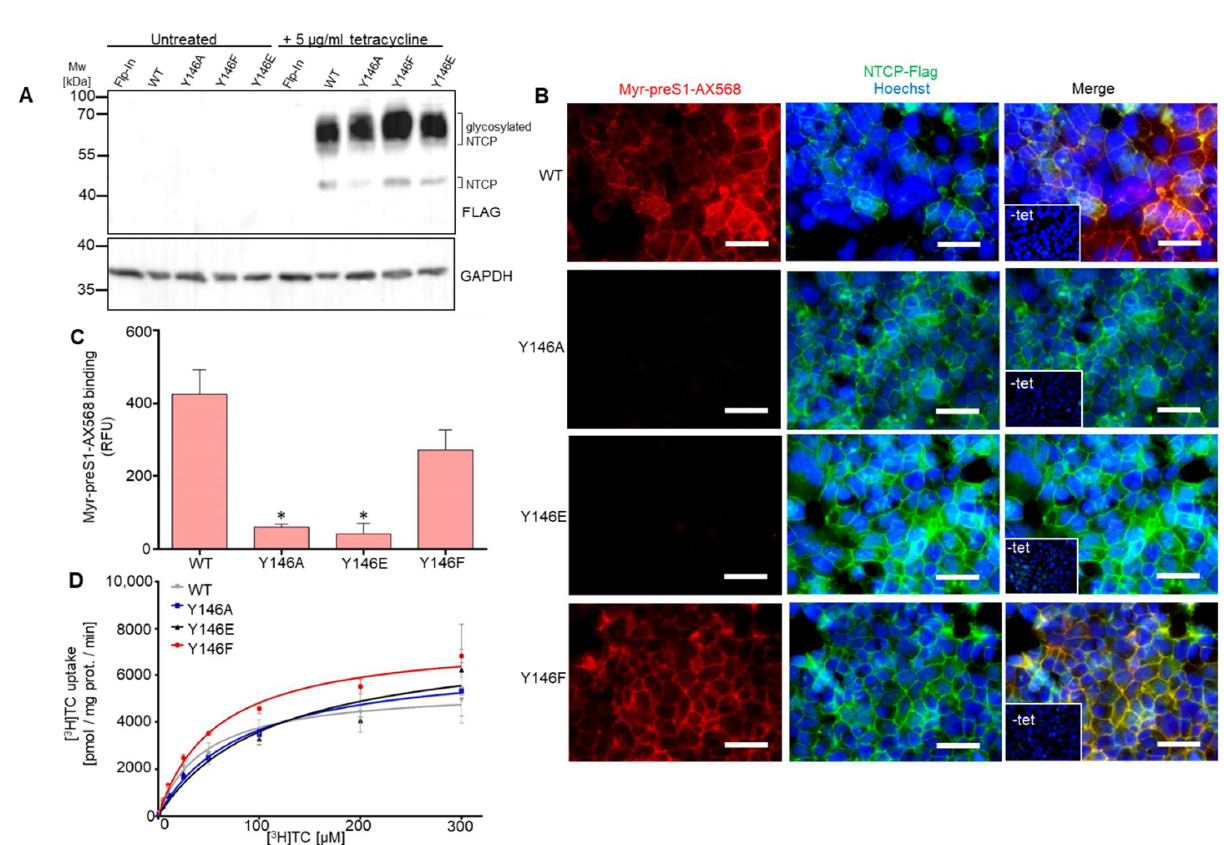
Figure 5. TC transport kinetics in stably NTCP-transfected HEK293 cell lines. In addition to wt NTCP, the cDNA constructs of the Y146A, Y146E, and Y146F mutants were stably transfected into the tetracycline-inducible T-Rex Flp-In HEK293 cells and single cell clones were selected. ( A ) NTCP protein expression in the stably transfected cell lines with or without addition of tetracycline (5 µg/mL) for 48 h. Cell lysates were processed for Western blot analysis using an anti-FLAG antibody. Expression of GAPDH served as loading control. MW, molecular weight marker. ( B ) Binding of the myr-preS1-AX568 peptide (red) to HEK293 cells stably expressing the wt NTCP, as well as the NTCP Y146A, Y146E, and Y146F mutants. The NTCP protein was counterstained with the rabbit anti-FLAG primary and the Alexa Fluor 488-labelled goat anti-rabbit secondary antibodies (green). Nuclei were visualized with Hoechst dye (blue). Scale bars: 40 µm. ( C ) For quantification of myr-preS1-AX568 peptide binding to NTCP, fluorescence images were captured on Leica DMI6000 B fluorescent microscope and fluorescence signals were quantified with the LAS-X imaging software (Leica) by determining cell-based fluorescence in defined regions of interest (ROI). Data are presented as mean background-subtracted relative fluorescence units ± SD of three independent experiments. EV, empty vector. * Significantly lower compared to wt NTCP with p < 0.001 according to one-way ANOVA with Dunnett’s multiple comparison post-hoc test. ( D ) Concentration-dependent uptake of [ 3 H]TC was analyzed in HEK293 cells stably expressing the wt NTCP, as well as the NTCP Y146A, Y146E, and Y146F mutants. Cells were treated with 5 µg/mL tetracycline for 48 h to induce carrier expression. Non-transfected T-Rex Flp-In HEK293 cells served as control. Specific uptake of [ 3 H]TC was calculated by subtracting non-specific uptake of the T-Rex Flp-In control cells from uptake into carrier-overexpressing HEK293 cells. The values represent means ± SD of three independent experiments.